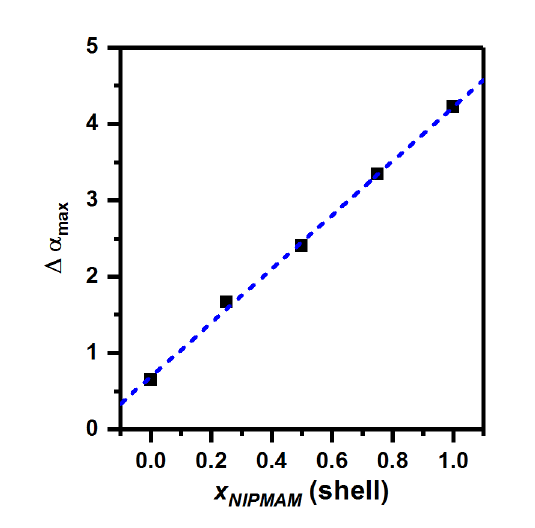
Figure 5. ∆ α max values, computed via Equations (1) and (2) plotted against the PNIPMAM fraction of the microgel-shell. The dashed blue line represents a linear fit of the